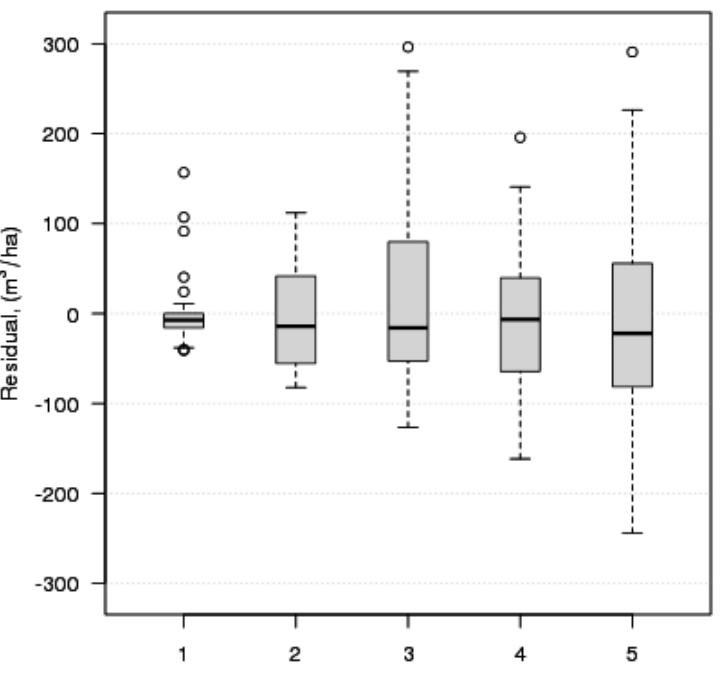
Figure 6. Volume residuals in volume prediction categories of 50 m 3 ∙ha −1